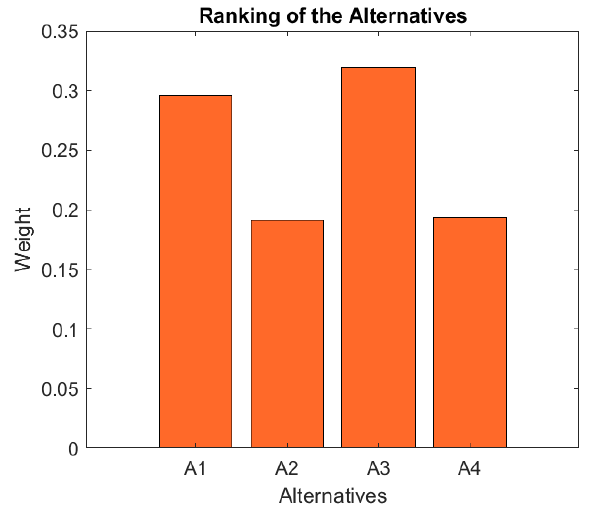
Figure 6. Ranking of the